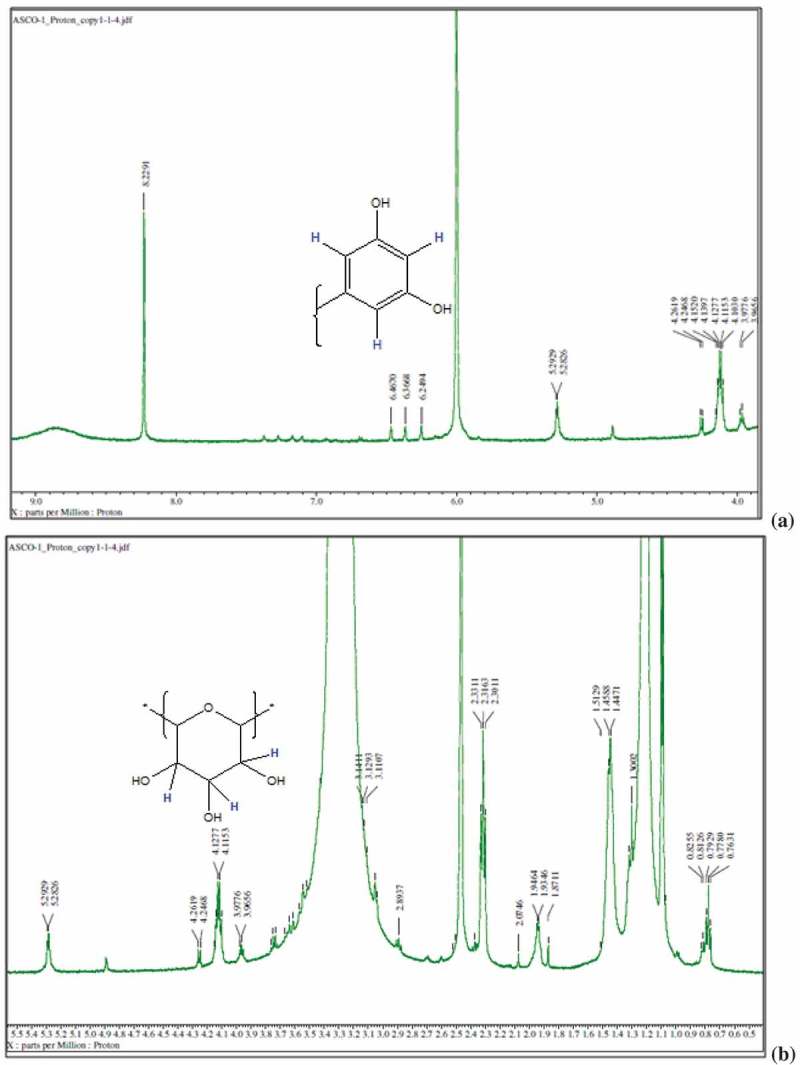
1H NMR spectra of compound I (ascotricin A).